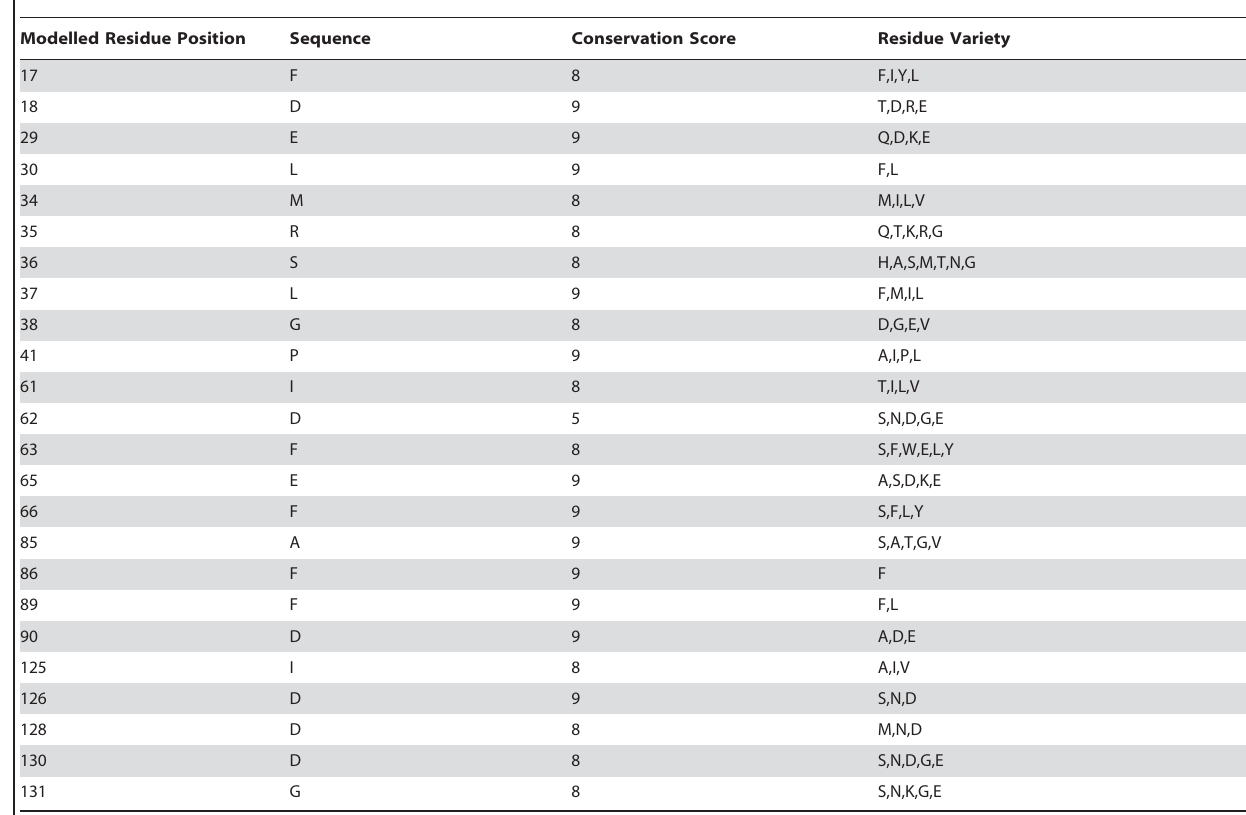
Table 3. Conservation score of CaM like Protein model (9-conserved, 1- variable).